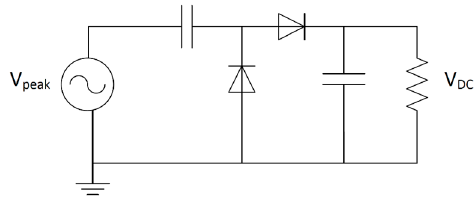
Figure 5. Voltage doubling circuit.